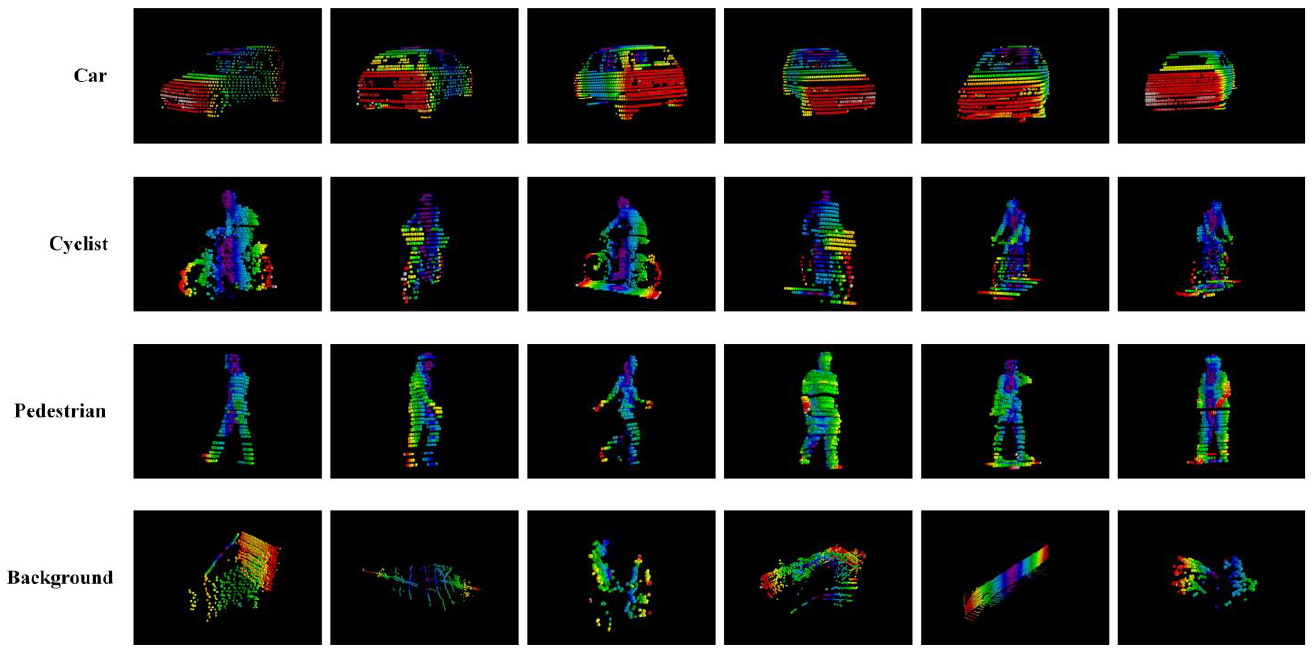
Figure 5. Visualization of different classes of targets in the KITTI dataset.